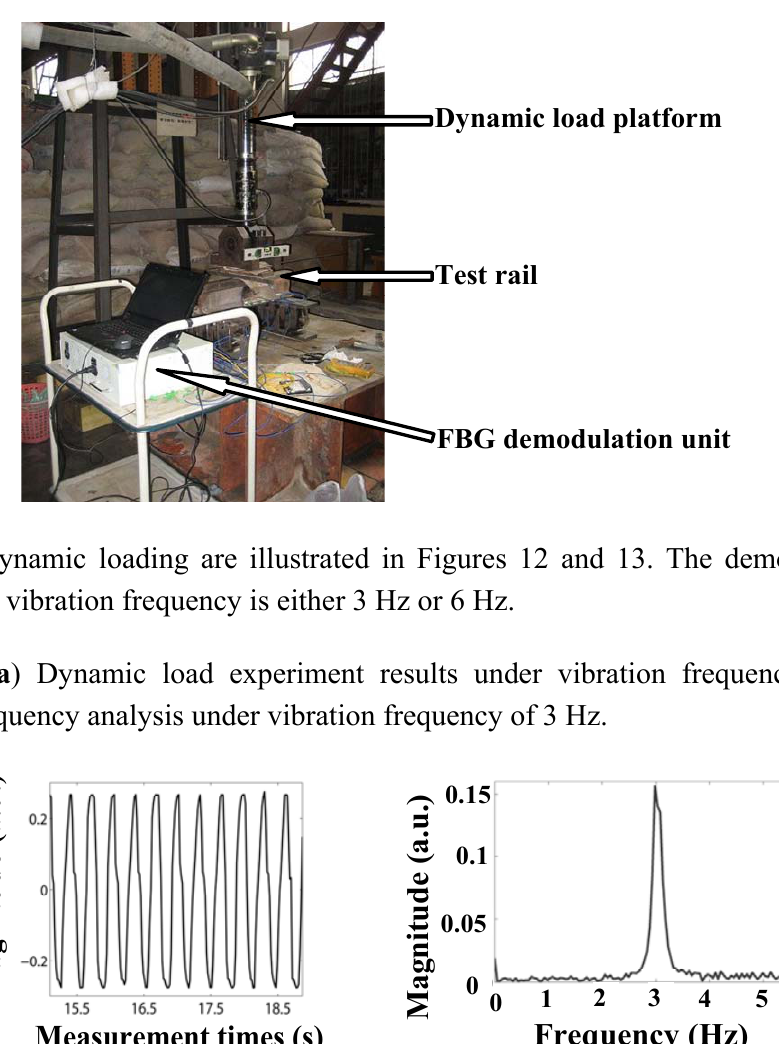
Figure 11. Dynamic rail load platform.